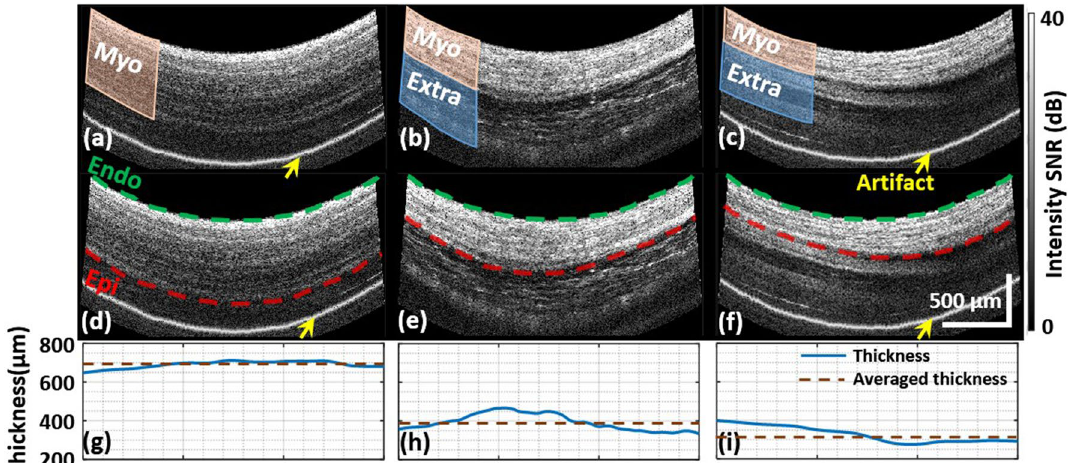
Figure 8. Illustration of the segmentation of myocardial wall. ( a – c ) are examples of structural images with different extra-myocardial tissue; ( d – f ) are the segmented endocardium and epicardium of ( a – c ), respectively; ( g – i ) are the wall thickness and averaged thickness of ( a – c ), respectively. The yellow arrows indicate reflection artifacts that originate within the imaging probe, which varies from probe to